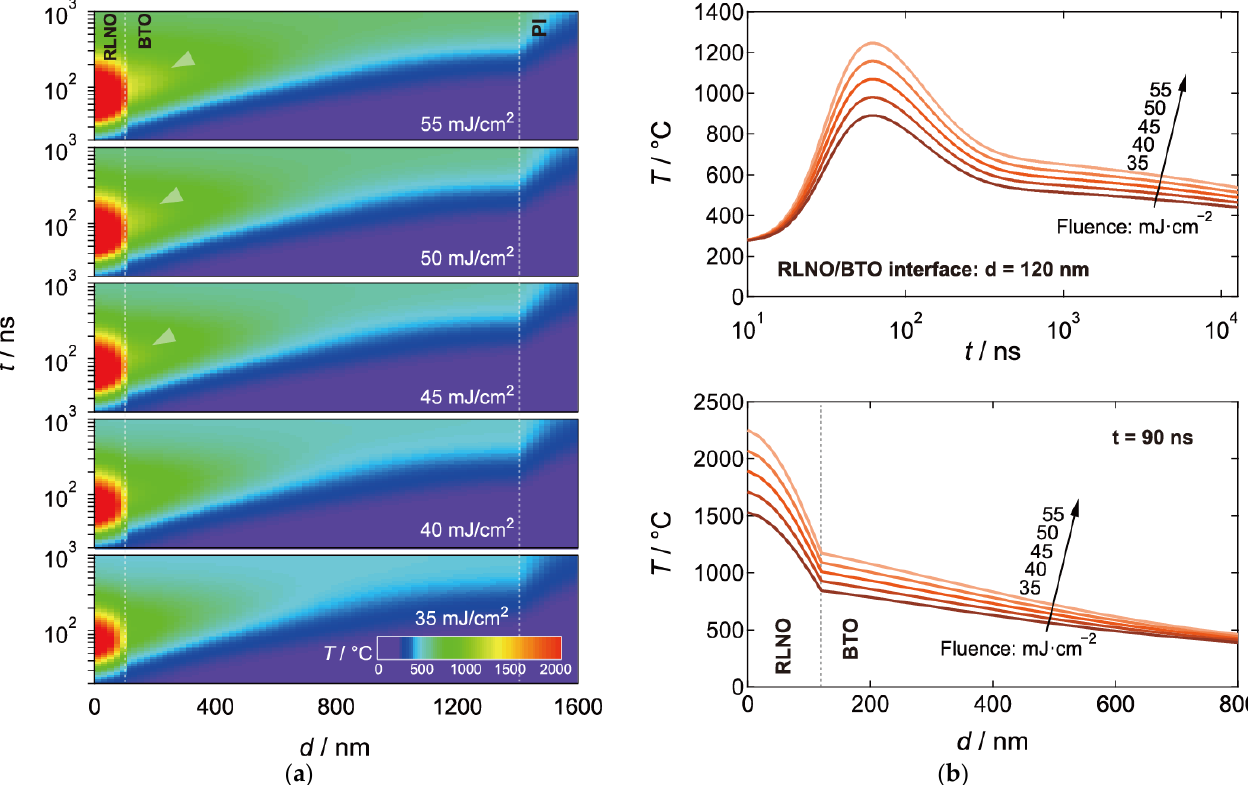
Figure 5. ( a ) Numerically simulated temperature maps across depth ( d ) and time ( t ) for the amorphous precursor RLNO thin film on a BTO/PI substrate irradiated at a KrF laser fluence of 35–55 mJ·cm − 2 . ( b ) Time dependence at the interface between RLNO and BTO ( d = 120 nm) and depth dependence ( t = 90 ns) of simulated temperature for the RLNO/BTO layers irradiated at a KrF laser fluence of 35–55 mJ·cm − 2 .